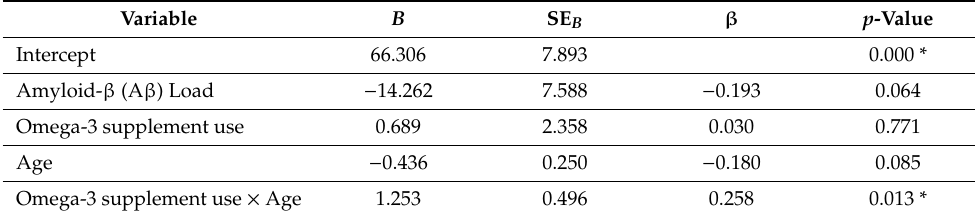
Table 2. Summary of multiple regression analysis results ( n = 90).